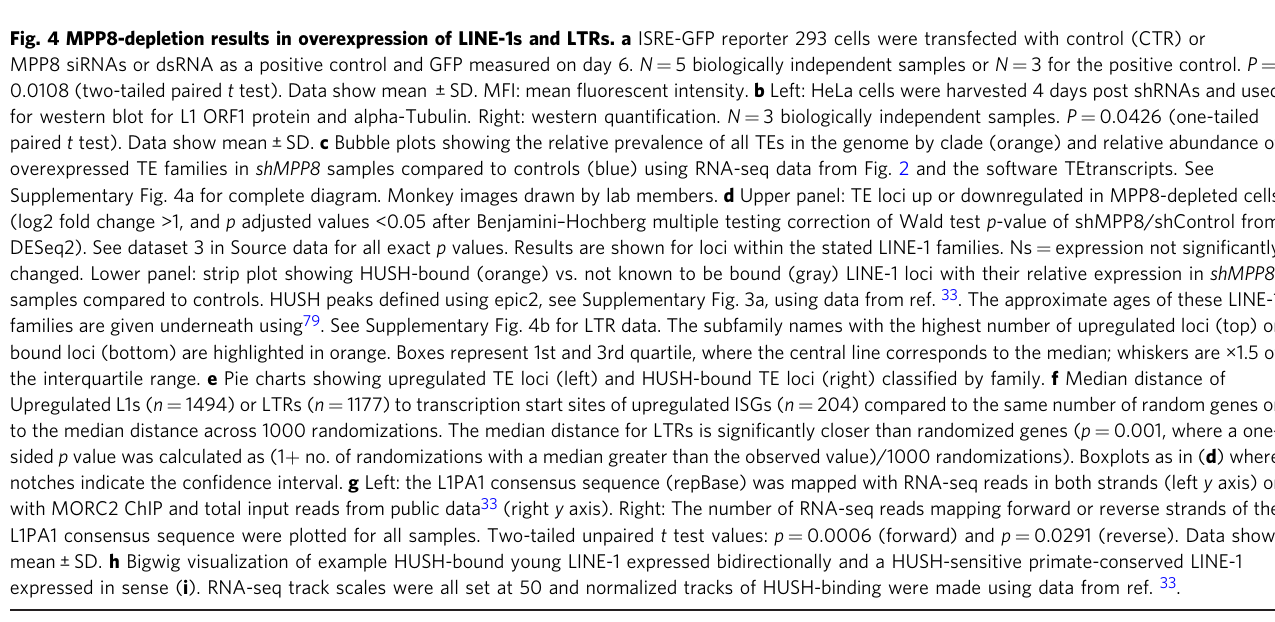
Fig. 4 MPP8-depletion results in overexpression of LINE-1s and LTRs. a ISRE-GFP reporter 293 cells were transfected with control (CTR) or MPP8 siRNAs or dsRNA as a positive control and GFP measured on day 6. N = 5 biologically independent samples or N = 3 for the positive control. P = 0.0108 (two-tailed paired t test). Data show mean ± SD. MFI: mean fl uorescent intensity. b Left: HeLa cells were harvested 4 days post shRNAs and used for western blot for L1 ORF1 protein and alpha-Tubulin. Right: western quanti fi cation. N = 3 biologically independent samples. P = 0.0426 (one-tailed paired t test). Data show mean ± SD. c Bubble plots showing the relative prevalence of all TEs in the genome by clade (orange) and relative abundance of overexpressed TE families in shMPP8 samples compared to controls (blue) using RNA-seq data from Fig. 2 and the software TEtranscripts. See Supplementary Fig. 4a for complete diagram. Monkey images drawn by lab members. d Upper panel: TE loci up or downregulated in MPP8-depleted cells (log2 fold change >1, and p adjusted values <0.05 after Benjamini – Hochberg multiple testing correction of Wald test p -value of shMPP8/shControl from DESeq2). See dataset 3 in Source data for all exact p values. Results are shown for loci within the stated LINE-1 families. Ns = expression not signi fi cantly changed. Lower panel: strip plot showing HUSH-bound (orange) vs. not known to be bound (gray) LINE-1 loci with their relative expression in shMPP8 samples compared to controls. HUSH peaks de fi ned using epic2, see Supplementary Fig. 3a, using data from ref. 33 . The approximate ages of these LINE-1 families are given underneath using 79 . See Supplementary Fig. 4b for LTR data. The subfamily names with the highest number of upregulated loci (top) or bound loci (bottom) are highlighted in orange. Boxes represent 1st and 3rd quartile, where the central line corresponds to the median; whiskers are ×1.5 of the interquartile range. e Pie charts showing upregulated TE loci (left) and HUSH-bound TE loci (right) classi fi ed by family. f Median distance of Upregulated L1s ( n = 1494) or LTRs ( n = 1177) to transcription start sites of upregulated ISGs ( n = 204) compared to the same number of random genes or to the median distance across 1000 randomizations. The median distance for LTRs is signi fi cantly closer than randomized genes ( p = 0.001, where a one- sided p value was calculated as (1 + no. of randomizations with a median greater than the observed value)/1000 randomizations). Boxplots as in ( d ) where notches indicate the con fi dence interval. g Left: the L1PA1 consensus sequence (repBase) was mapped with RNA-seq reads in both strands (left y axis) or with MORC2 ChIP and total input reads from public data 33 (right y axis). Right: The number of RNA-seq reads mapping forward or reverse strands of the L1PA1 consensus sequence were plotted for all samples. Two-tailed unpaired t test values: p = 0.0006 (forward) and p = 0.0291 (reverse). Data show mean ± SD. h Bigwig visualization of example HUSH-bound young LINE-1 expressed bidirectionally and a HUSH-sensitive primate-conserved LINE-1 expressed in sense ( i ). RNA-seq track scales were all set at 50 and normalized tracks of HUSH-binding were made using data from ref. 33